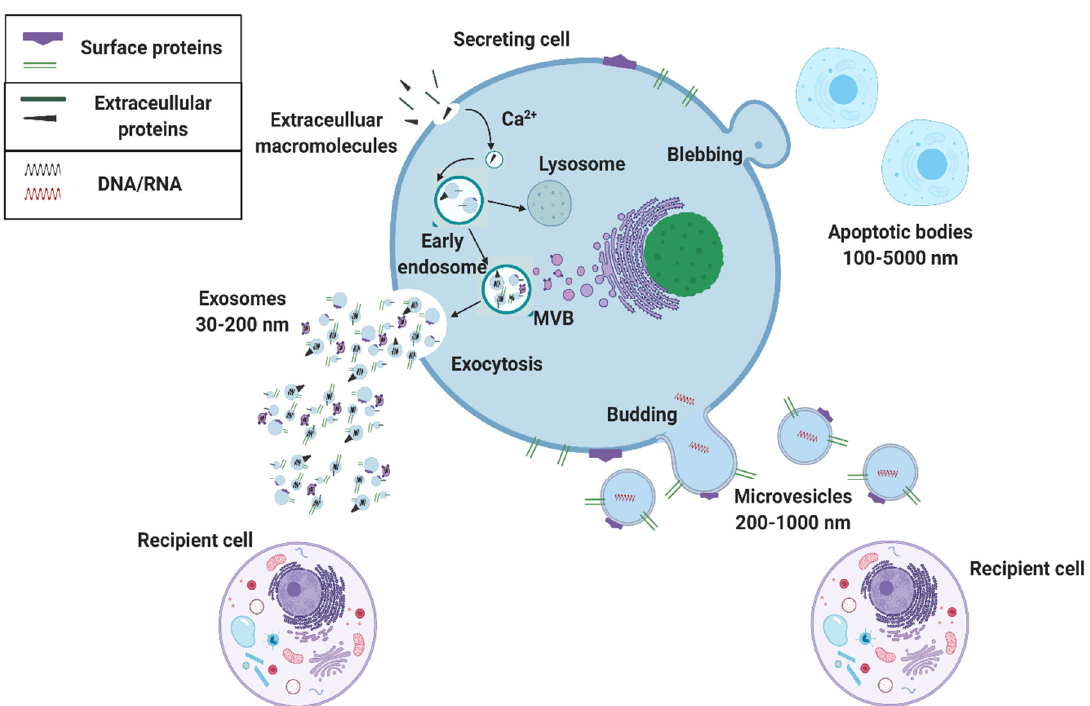
Figure 2. Extracellular vesicle biogenesis. Extracellular vesicles that are secreted from a cell include apoptotic bodies (100– 5000 nm), microvesicles (200–1000 nm), and exosomes (30–200 nm). Exosomes are made from an early endosome pathway and can contain information about both the parent cell’s organelles and plasma membrane, whereas microvesicles merely bud and contain membrane information from the parent cell’s surface membrane.